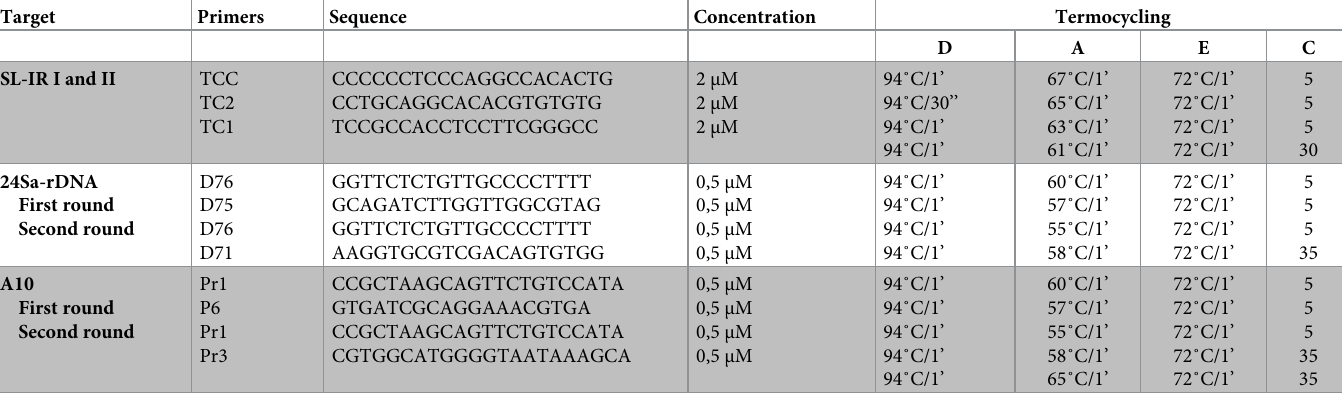
Table 2. Primers and conditions for Trypanosoma cruzi molecular